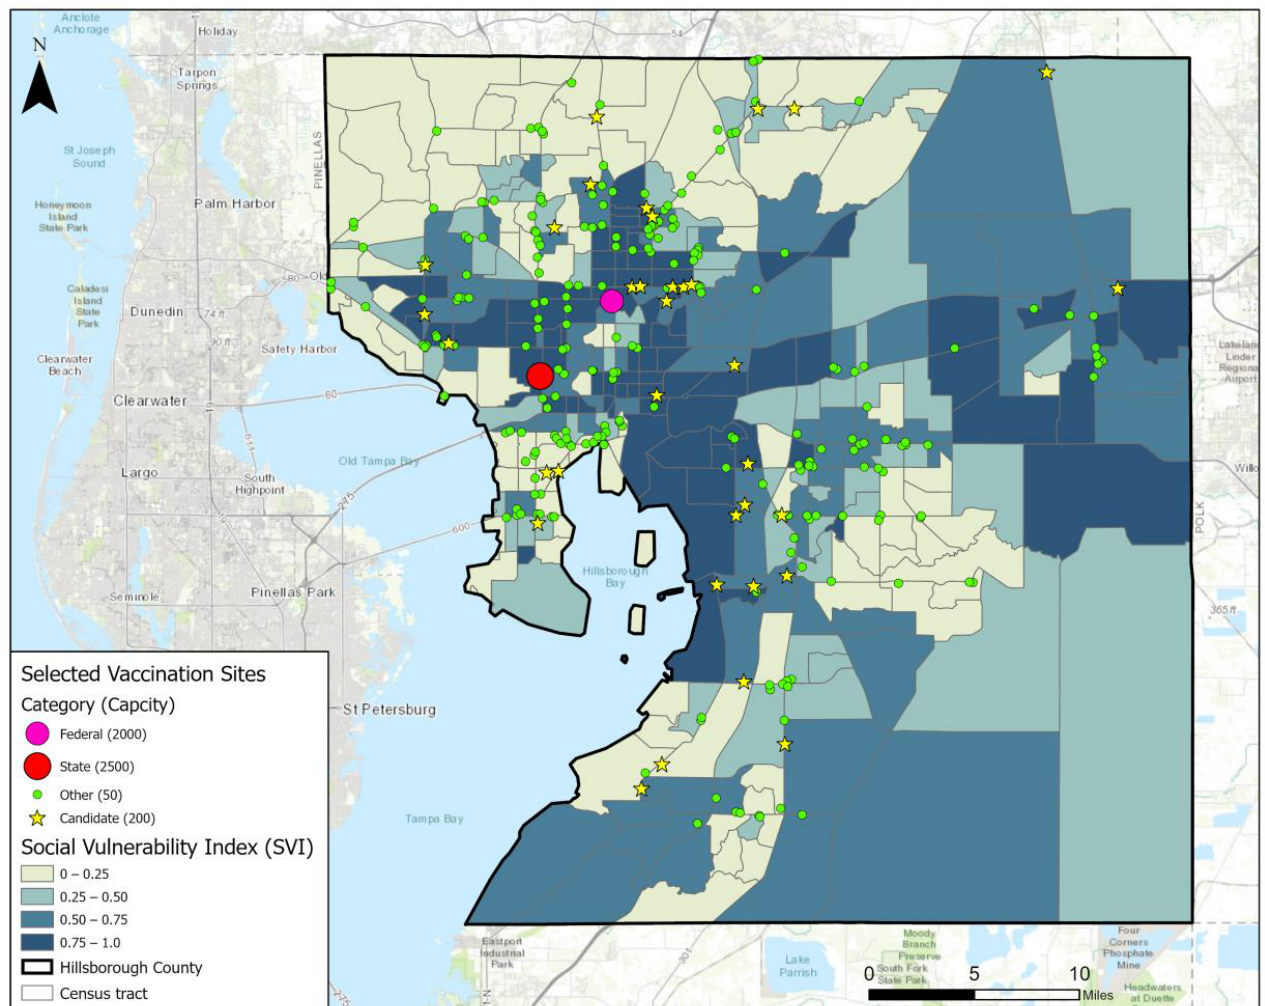
Figure 3. Case 4 result map with selected vaccination site